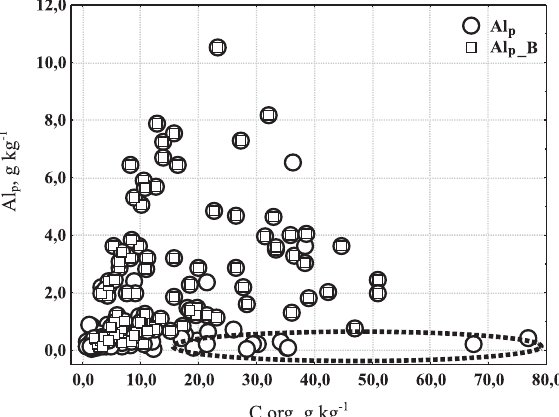
Figura 6. Relação entre o teor de carbono orgânico (Corg) e o de Al extraído por pirofosfato (Al ). As p amostras designadas de Al referem-se à rela- p ção entre Corg e Al de todos os horizontes aqui p estudados (horizontes A, E, B, C e intermediári- _Bh refe- os), com valores diferentes de zero. A p re-se à relação entre o Corg e o conjunto de da- dos dos horizontes espódicos. Elipse circunda alguns horizontes superficiais do tipo A que apre- sentaram baixos conteúdos de Al e que pouco p variaram com o aumento do Corg.